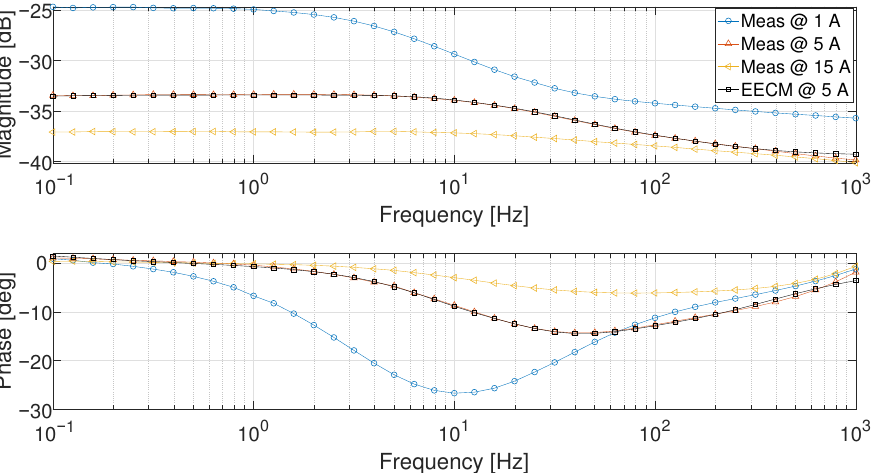
Figure 24. Bode diagrams of the averaged real measurements at 1A, 5A, and 15A and the EECM evaluated at the current working point of 5A